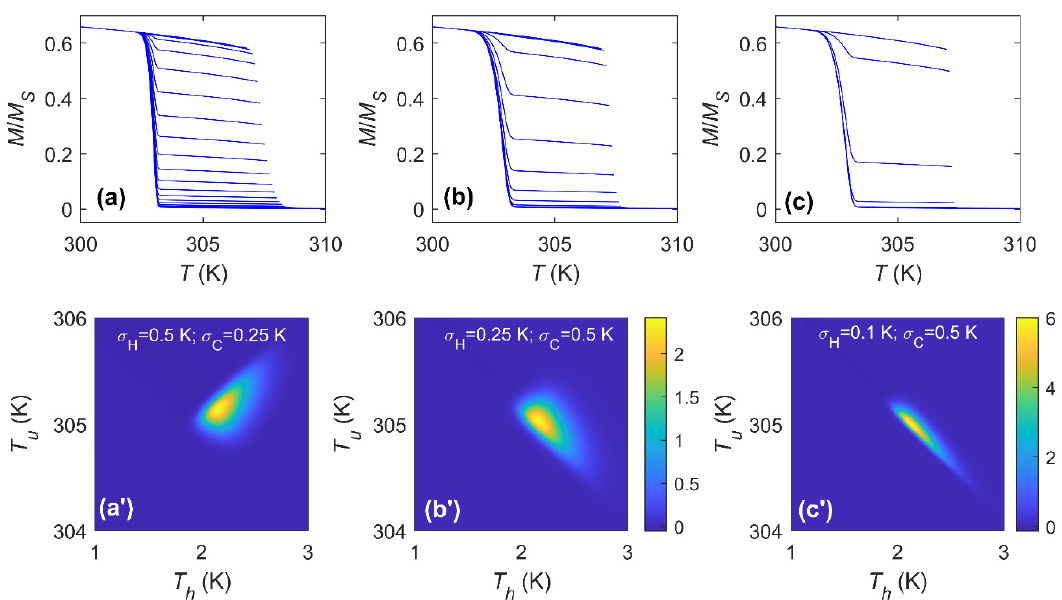
Figure 9. Cooling first order reversal magnetization curves and associated TFORC distributions with ξ H = T t , ST + 2 K, ξ C = T t , ST − 2 K, α H = α C = 4 and ( a – a’ ) σ H = 0.5 K, σ C = 0.25 K, ( b )–( b’ ) (cid:2026) (cid:3009) = 0.25 K , (cid:2026) (cid:3004) = 0.5 K , ( c )–( c’ ) (cid:2026) (cid:3009) = 0.1 K , (cid:2026) (cid:3004) = 0.5 K .